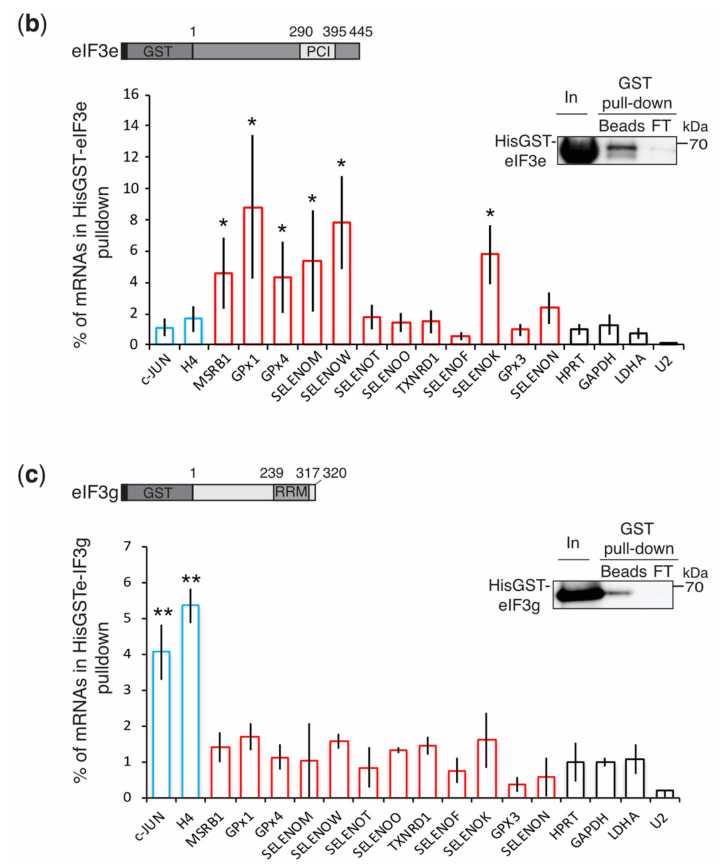
Figure 4. Interaction analysis of HisGSTeIF3 d, e, and g with selenoprotein mRNAs. ( a – c ) GST pull-down results for HisGST-eIF3d, HisGST-eIF3e, and HisGST-eIF3g and qRT-PCR analysis of bound RNAs. The schematic representation of the proteins and the Western blot panels confirming the pull-down of the HisGST target proteins are included above the histograms. eIF3e contains a C-terminal PCI domain and eIF3g a C-terminal RNA Recognition Motif (RRM). Data are presented as described in Figure 3. The GST pull-down experiments and the Western blots presented are the same as those previously published in [35]. Adapted with permission from Ref. [35]. Copyright 2021, CC BY License, copyright to The authors and American Society for Biochemistry and Molecular